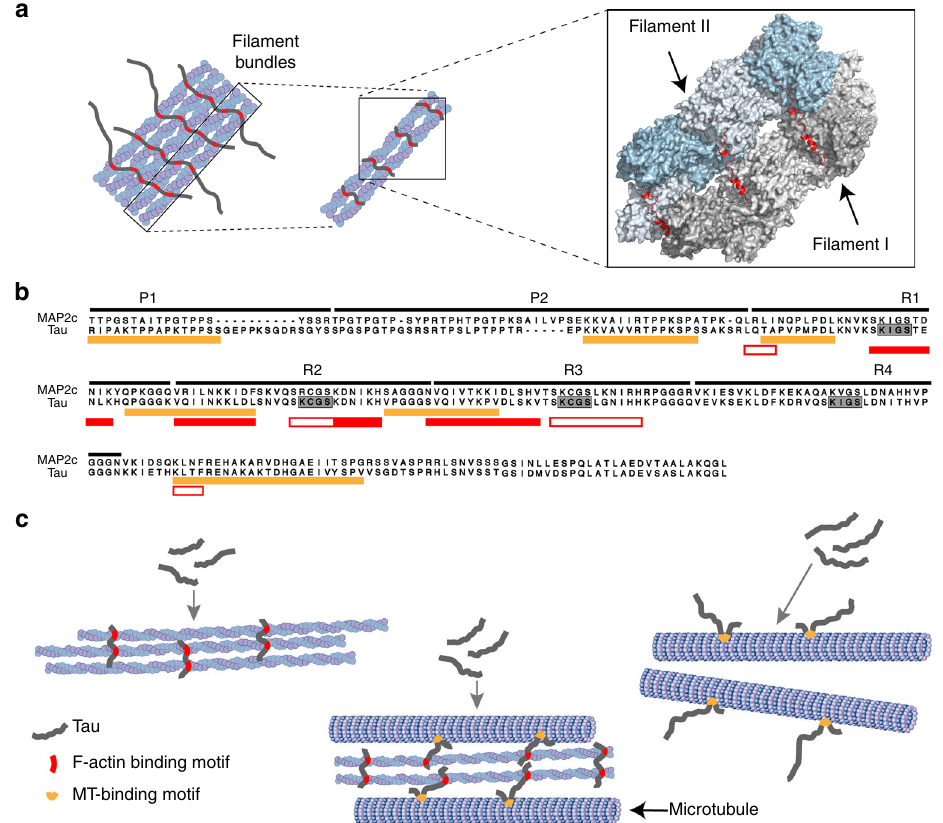
Fig. 5 Model of Tau-driven actin bundling F-actin/microtubule network formation. a Schematic representation of cross-linking of actin fi laments by helices of Tau, which are separated by fl exible linkers. Each helix (shown in red) is bound to a hydrophobic actin pocket in a neighboring fi lament (gray and light blue). b Sequence alignment of the repeat domains of MAP2c and Tau. Tau residues, which bind to F-actin, are marked by red open bars, experimentally proven F-actin interacting regions by red fi lled bars, and microtubule-binding sites in orange. KXGS motifs are highlighted. c Because Tau contains multiple interaction sites for both F-actin (this work) and microtubules 72 , Tau can cross-link the cellular cytoskeleton 7 . While short segments in the repeat domain fold into helical structure (red) in complex with F-actin, Tau residues in complex with microtubules form a microtubule-speci fi c hairpin structure (orange 46